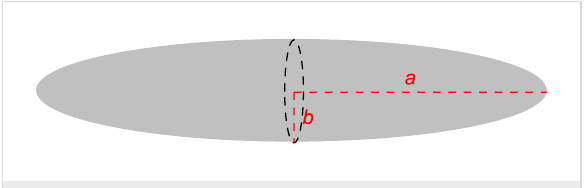
Figure 15: Scheme of a stretched rotation ellipsoid with the semi- major axes a and b